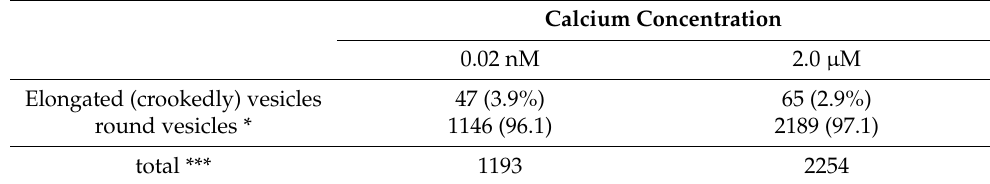
Table 2. Number of elongated and round-types of vesicles, observed at 0.04 nM and 2.0 µ M Ca 2+ in the absence of ATP. The SR vesicles were incubated with each concentration of Ca 2+ and without ATP at pH 7.4 and 0 ◦ C overnight. For the analysis, 8–13 images were recorded at each calcium concentration (0.04 nM and 2.0 µ M Ca 2+ ). The regions and populations imaged were not specifically selected, and were different to the regions/populations employed for Table 1. For each concentration, the vesicle populations (84–221) within each of the 4.5 µ m by 4.5 µ m regions imaged were subjected to vesicle classification; the resulting data are summarized in the table (see text for details). The number of each type of vesicles relative to the total number of vesicles (elongated and round), at the respective calcium concentration is given as a percentage in parenthesis. All of the elongated vesicles observed were crooked and without a crystalline array (Figure 9b,d). Calcium Concentration 0.02 nM 2.0 µ M Elongated (crookedly) vesicles 47 (3.9%) 65 (2.9%) round vesicles * 1146 (96.1) 2189 (97.1) total *** 1193 2254